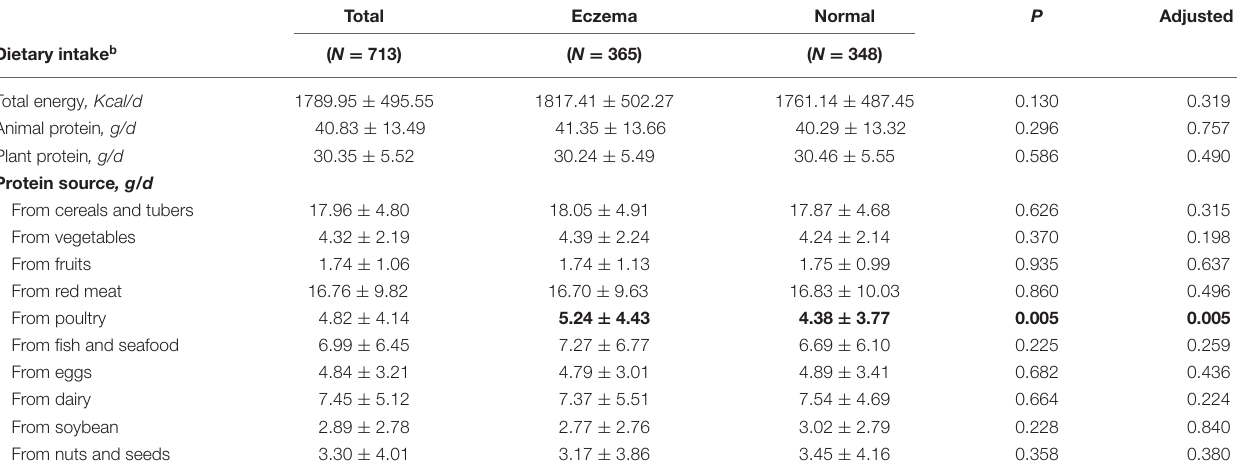
TABLE 2 | Dietary consumption in a cohort study by categories of eczema a . Total Eczema Normal P Adjusted P c Dietary intake b ( N = 713) ( N = 348) Total energy ,